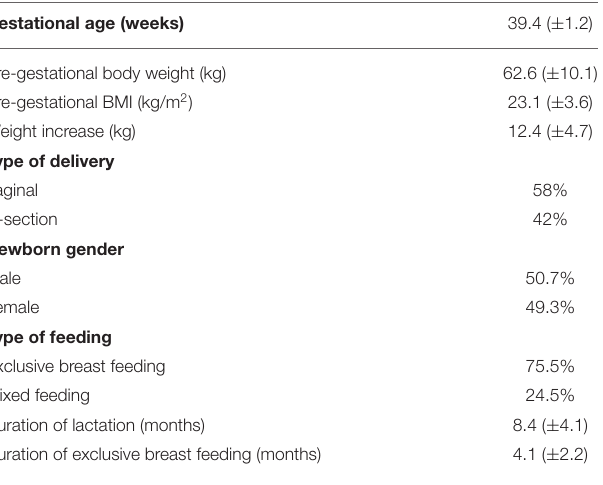
TABLE 1 | Characteristics of the study subjects having breast milk sample to assess lipidome ( n =